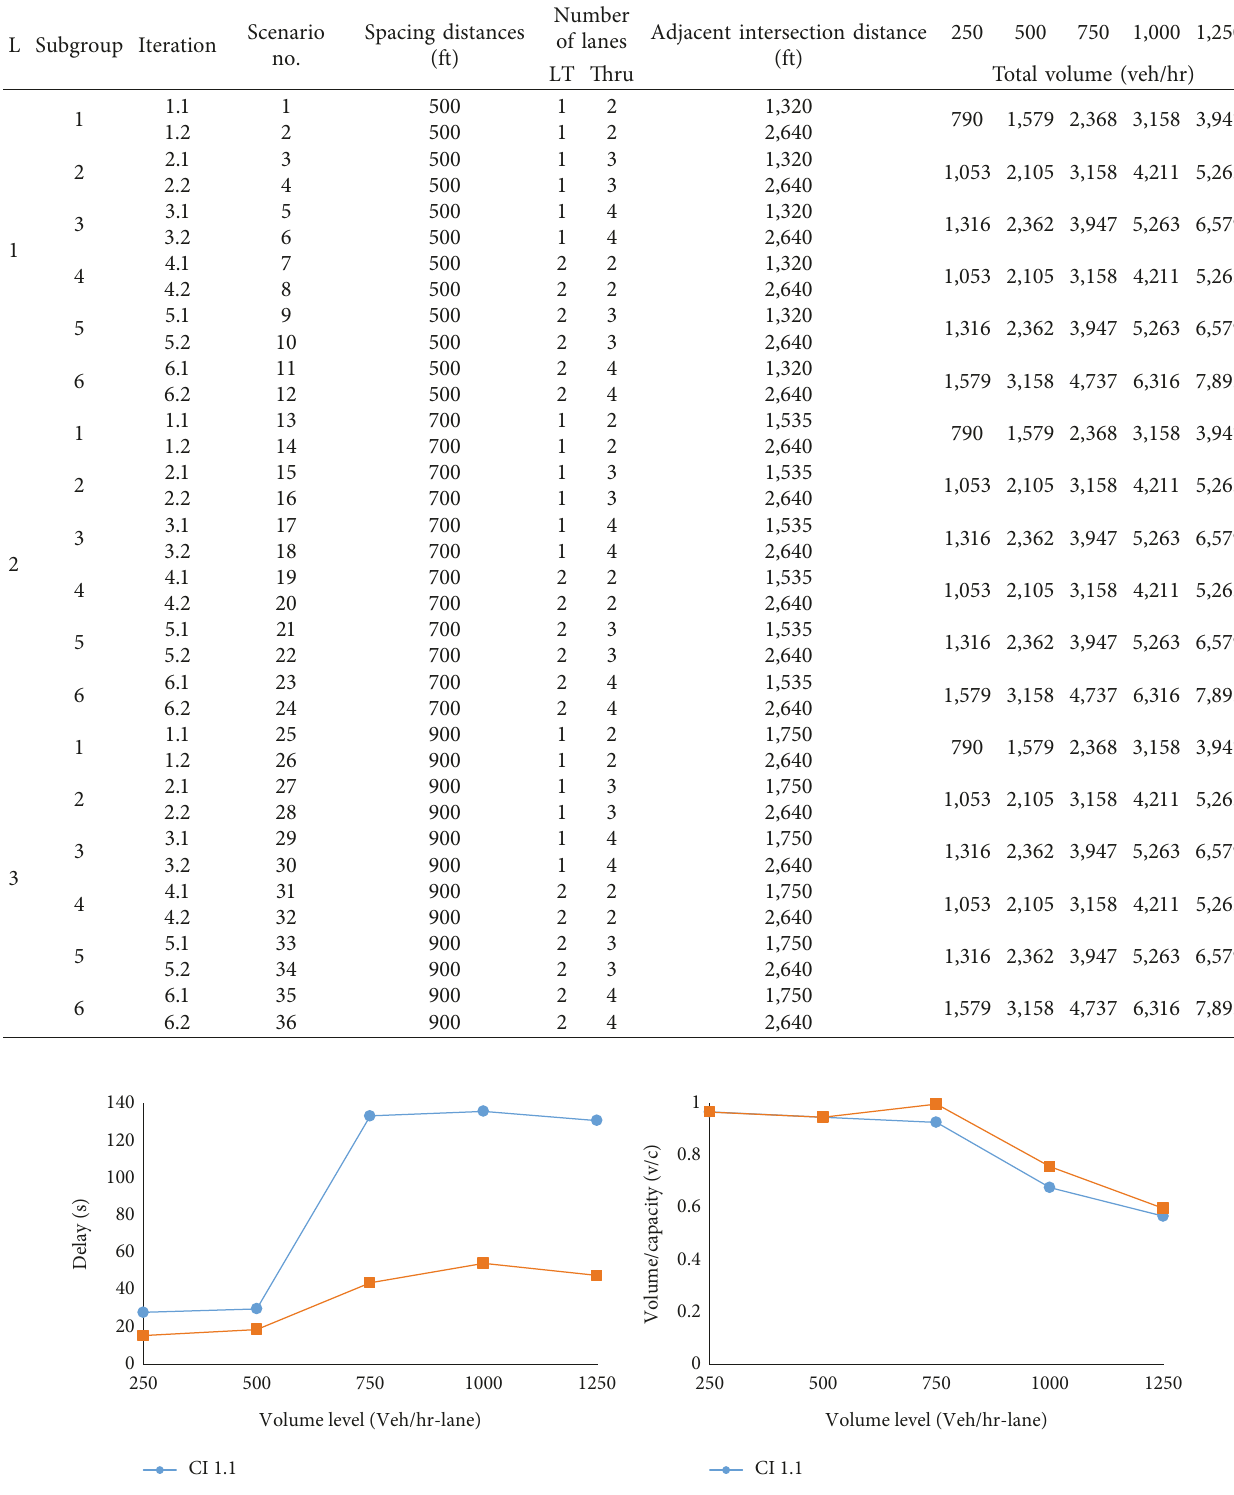
Table 2: Experimental design description.